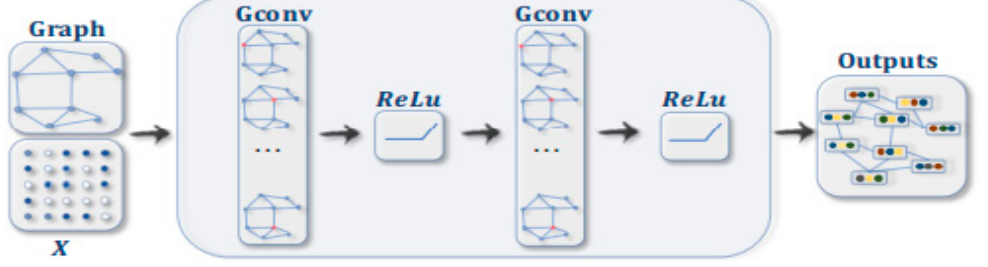
Figure 12. A general architecture of a GCN.